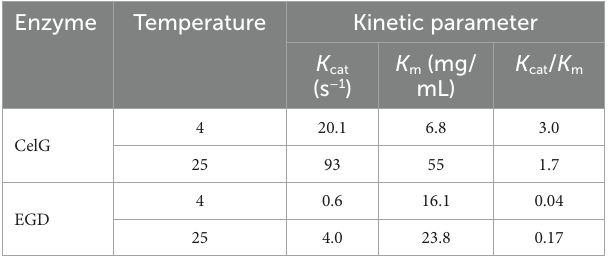
TABLE 5 Kinetic parameters of Fibrobacter succinogenes S85 CelG and EGD (Iyo and Forsberg, 1999). Enzyme Temperature Kinetic